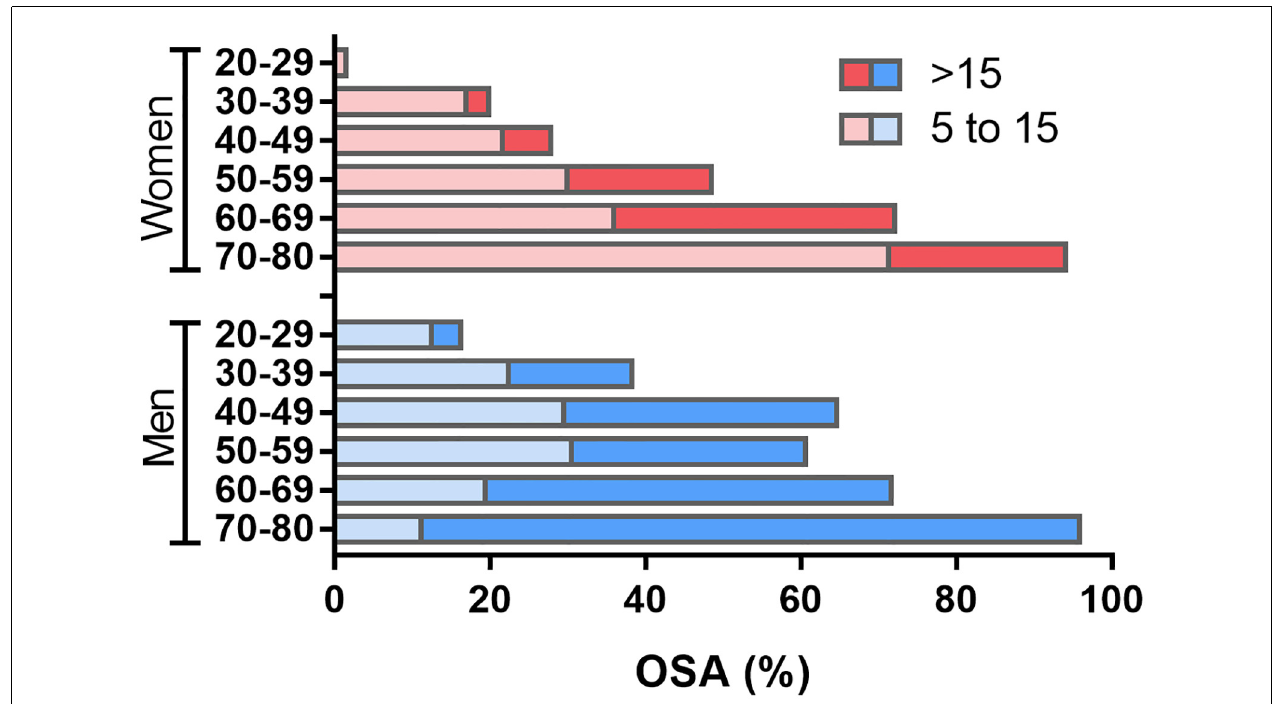
FIGURE 3 | Prevalence of obstructive sleep apnea (OSA) from 20–80 years old. Data are presented for each 20 years range, separately for men and women. Apnea-Hypopnea Index (AHI) ranging from 5–15 represents mild OSA, while an AHI>15 represents moderate to severe OSA. Considering the older adult population, the prevalence of OSA is remarkably high, but the proportion of moderate to severe OSA is higher among men, while mild OSA is more common among women. Values refer to the prevalence obtained in the São Paulo Epidemiologic Sleep Study. Adapted from Tufik et al.